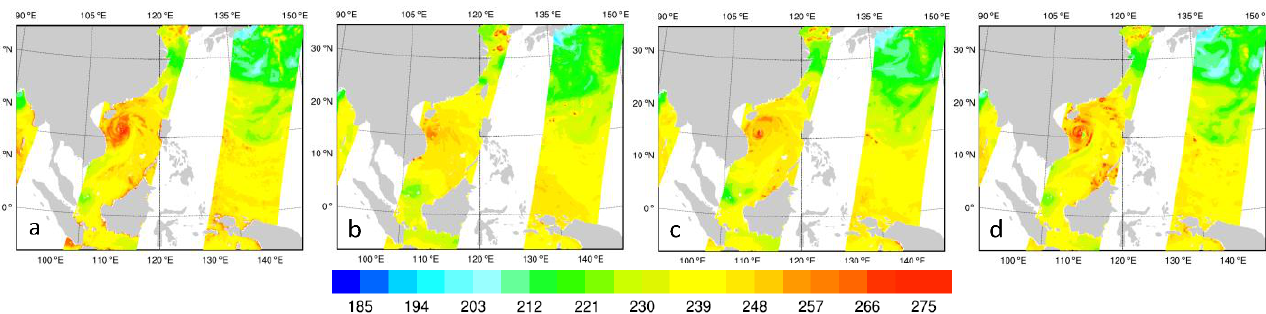
Figure 6. The analyzed brightness temperatures (K) of MWRI 23.8 GHz-V channel 5 from ( a ) observation, ( b ) CTRL, ( c ) CON, and ( d ) AMWRI experiments at 1800 UTC on 26 October.